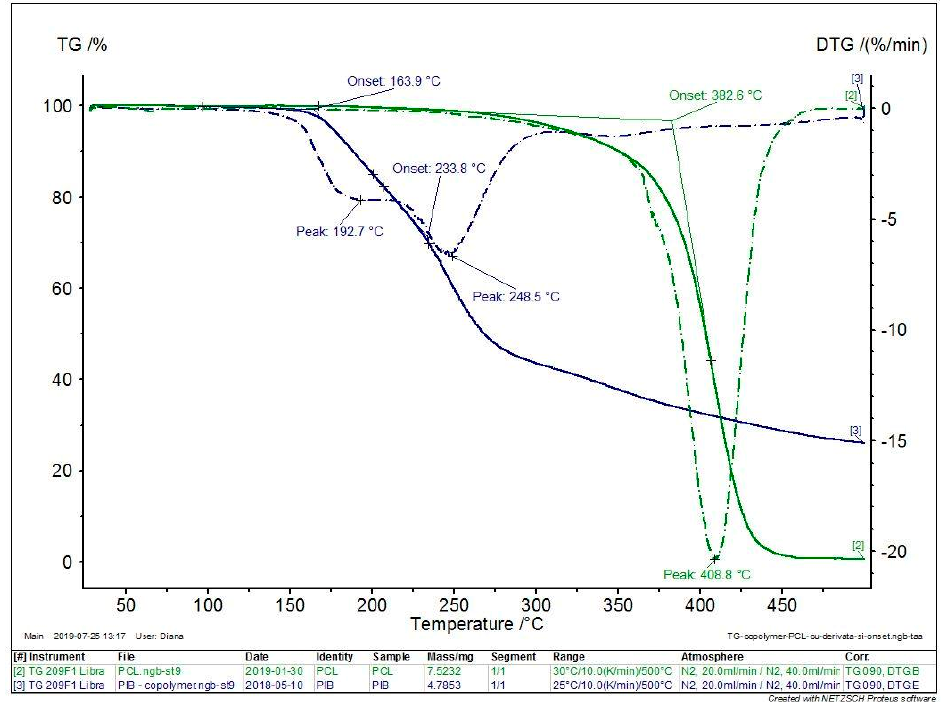
Figure 4. The thermograms of HMFA_ECL copolymers (blue), compared to the PCL homopolymer (green). Table 3. Thermal properties of the HMFA_ECL copolymer, compared to the PCL homopolymer.